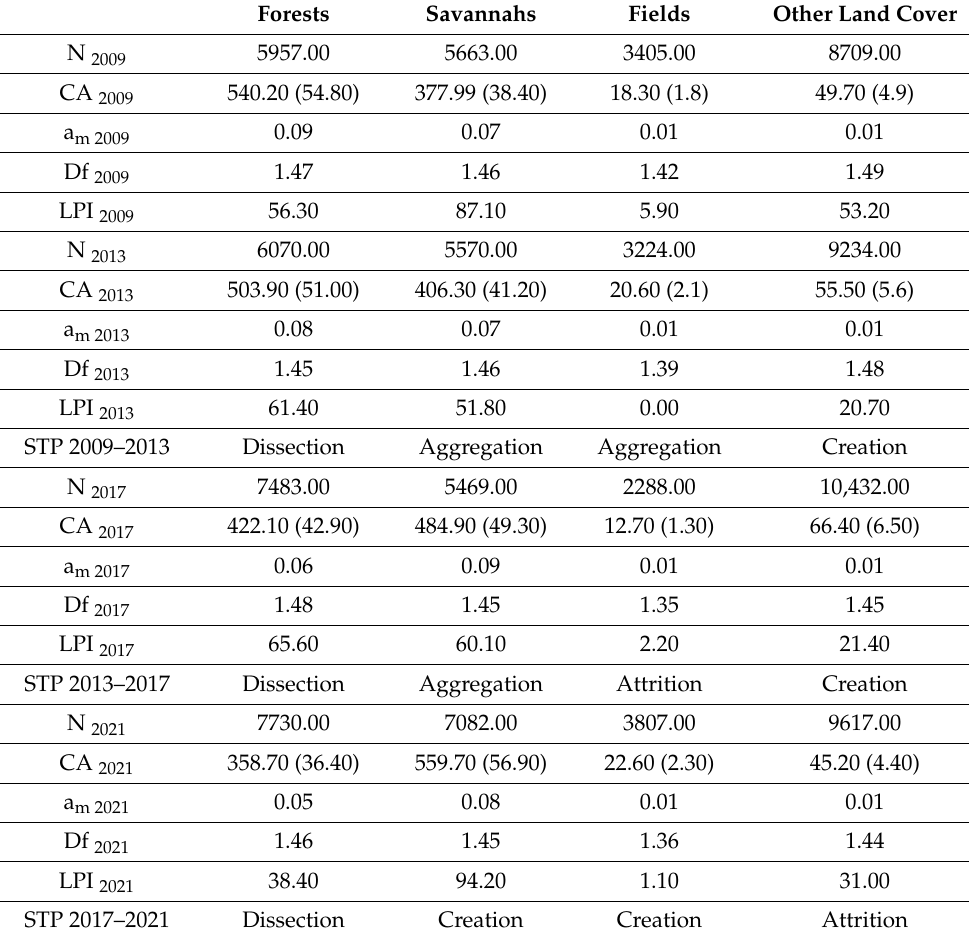
Dissection Creation Creation